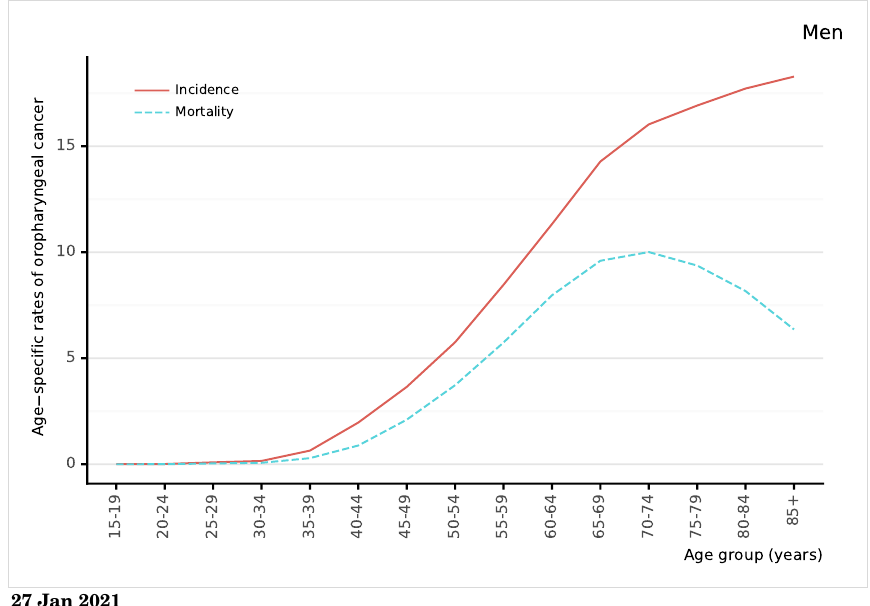
Figure 40: Comparison of age-specific oropharyngeal cancer incidence and mortality rates among men in India (estimates for 2020)